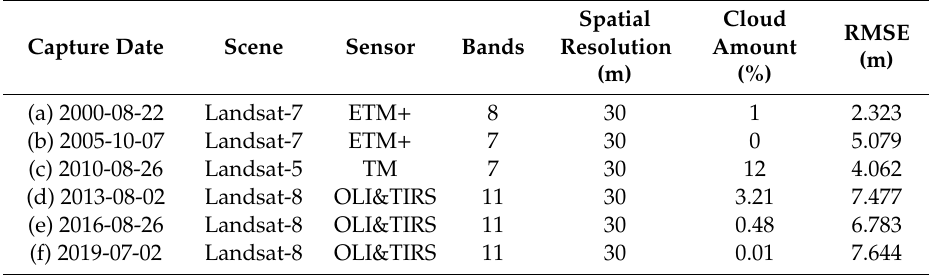
Table 1. Satellite imagery used in this